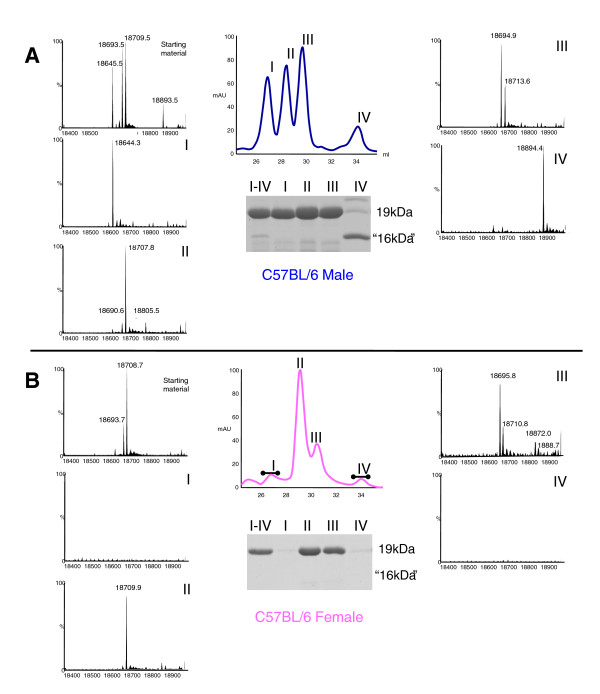
Separation of urinary proteins in B6 mouse urine by anion exchange chromatography. Urinary proteins from (A) adult male and (B) adult female B6 mice were separated by strong anion-exchange chromatography, monitored by ultraviolet (UV) absorbance (central trace, blue or pink line). Four specific fractions corresponding to peak UV absorbance were collected from male urine, together with the corresponding fractions from female urine (I - IV). The protein masses in each of these four fractions, along with unfractionated MUPs, were analysed by electrospray ionisation mass spectrometry (outer traces), confirming that each mass corresponded to a known MUP mass in B6 mice [28]. Male fractions I and IV each contained a single male-specific MUP with a mass that was not detectable in matching female fractions. Resolution of each fraction on SDS-PAGE confirmed the absence of MUPs in female fractions I and IV, while male fraction IV contained the male-specific high mobility 18893Da MUP, darcin.